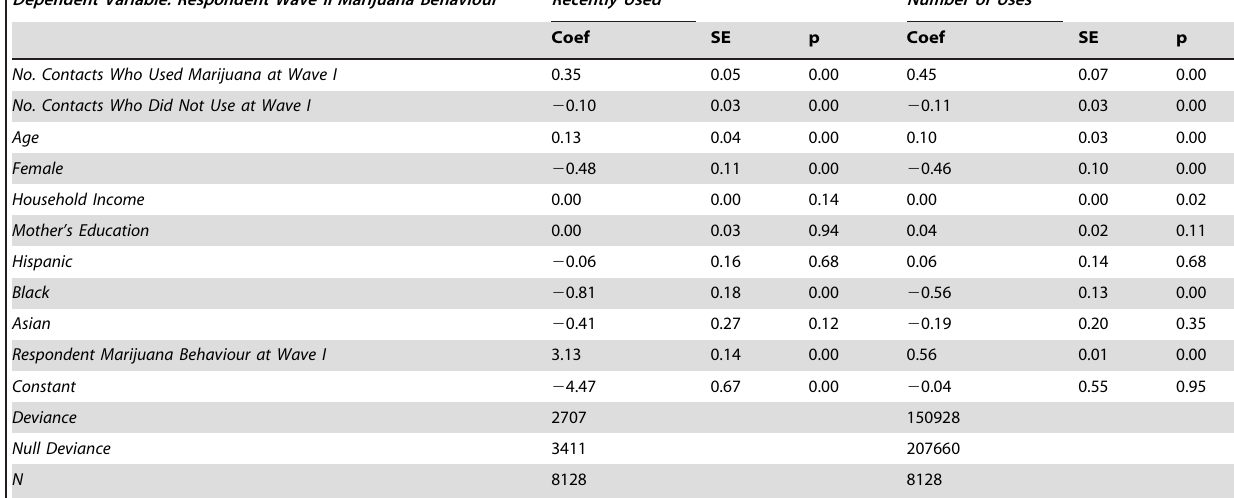
Table 2. Marijuana use and social contacts.